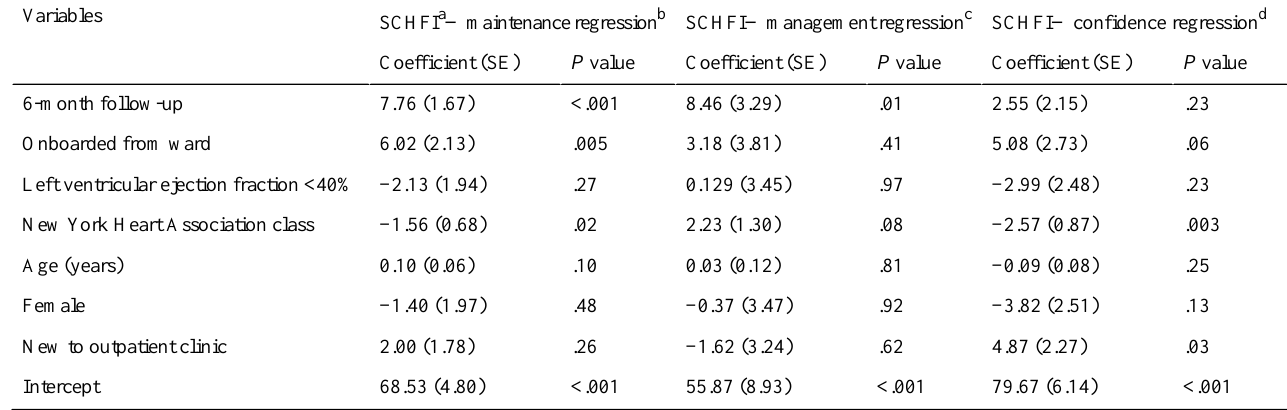
Table 5. Linear regressions showing the effect of 6 months in the Medly program on self-care maintenance, management, and confidence when controlled for key demographic and clinical